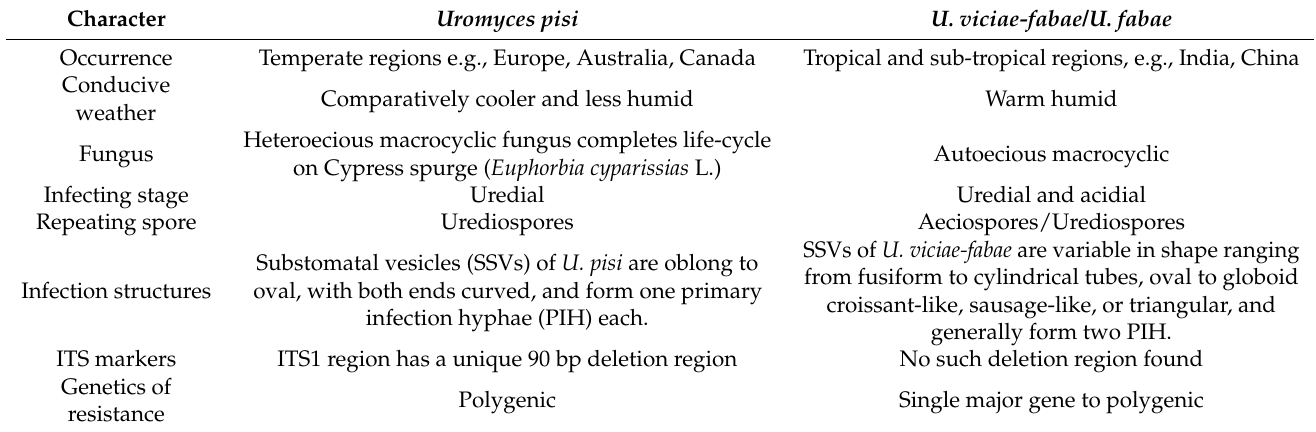
Table 1. Distinguishing features of two types of Uromyces rust